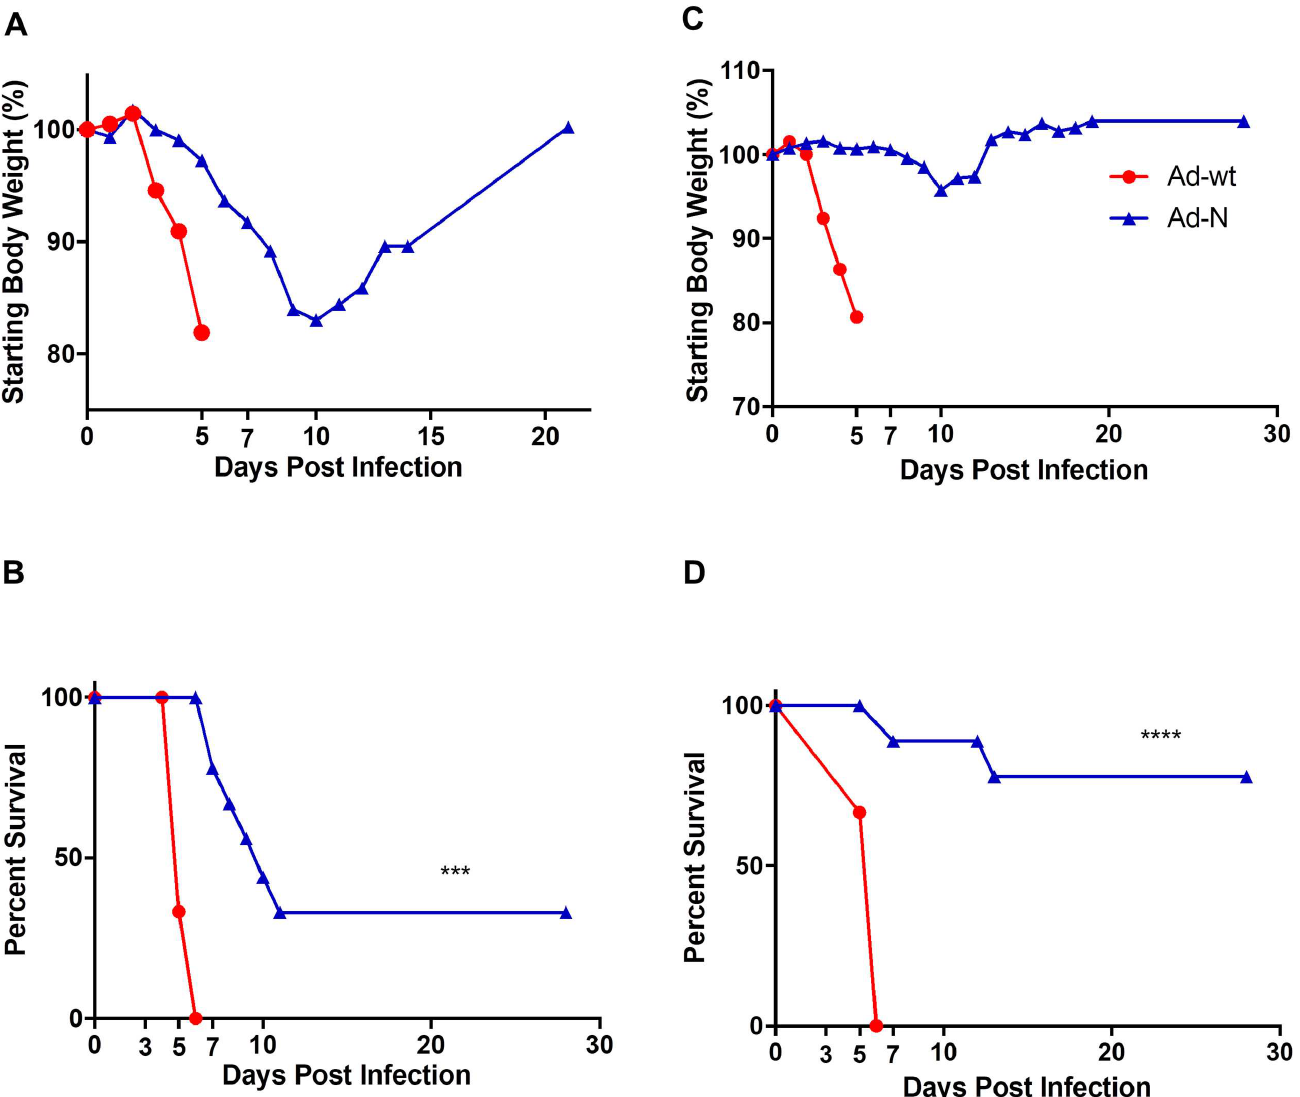
Fig 1. Efficacy of single-dose and prime-boost vaccination. (A,B) Single-dose vaccination. IFNAR -/- mice (n = 9 for Ad-N; n = 6 for Ad-wt) were vaccinated with recombinant adenoviruses (1.25 × 10 7 ifu) 28 days prior to lethal CCHFV infection (1000 LD 50 ). The animals were monitored for weight as a group (A) and disease progression/survival (B) over 30 days. (C,D) Prime-boost vaccination. IFNAR -/- mice (n = 9 for Ad-N; n = 3 for Ad-wt) were vaccinated with recombinant adenoviruses 56 (1.25×10 7 IFU; intramuscular) and 28 (10 8 IFU; intranasal) days prior to lethal CCHFV infection (1000 LD 50 ). The animals were monitored for weight (C) and disease progression/survival (D) over 30 days. Data is reported as the means. (cid:3)(cid:3)(cid:3) p < 0.001, (cid:3)(cid:3)(cid:3)(cid:3) p < 0.0001.